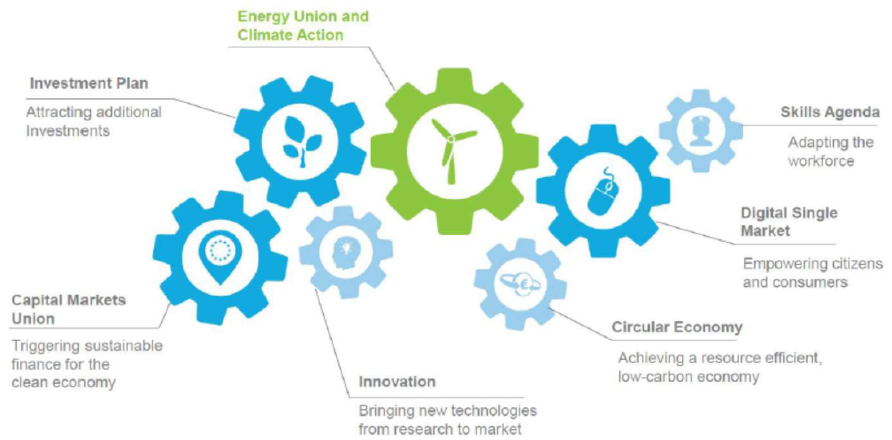
Figure 2. Role of the energy union and climate action. Source: [23].